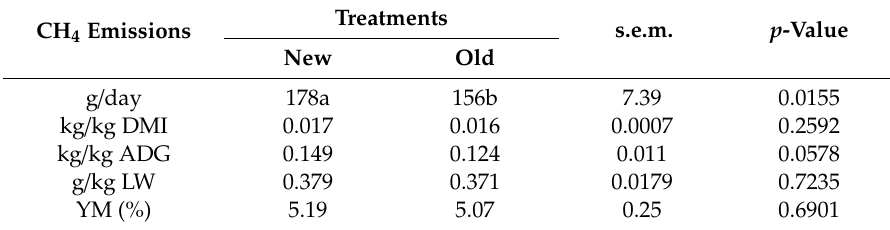
Table 6. Methane emission factors of Canchim steers from di ff erent lines finished in feedlot. CH 4 Emissions